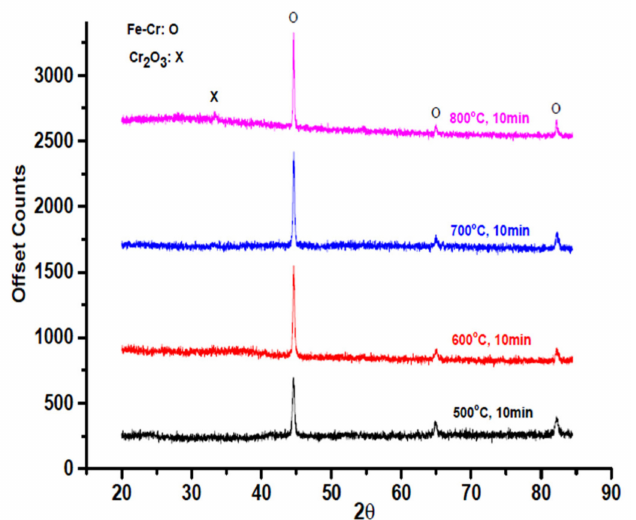
Figure 4. Oxide scale thicknesses as revealed in cross-sectional analysis through transmission electron